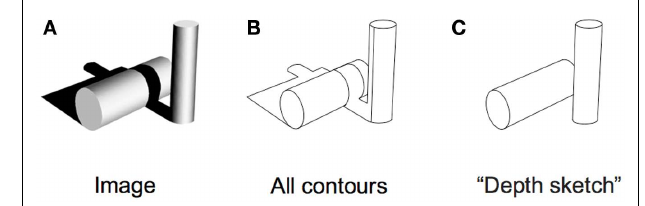
FIGURE 3 | (A) Original image with objects and shadows. (B) Extracted contours from the original do not capture the underlying scene very well. (C) A depth sketch revealing the two actual objects in the scene.